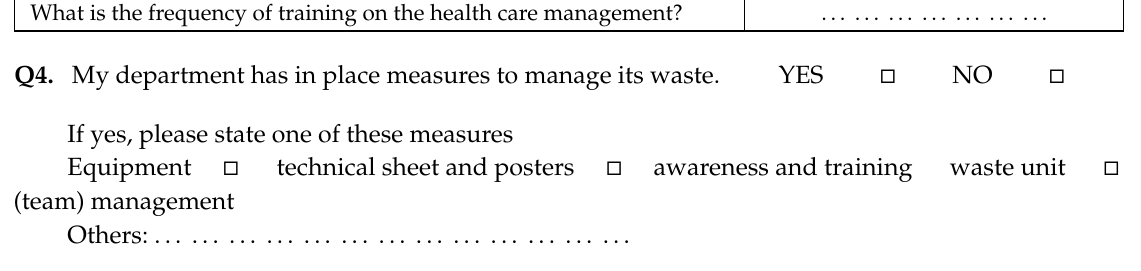
The Trust has an infection control policy Specific training in waste management forms a part of my job Specific training in infection control forms a part of my job